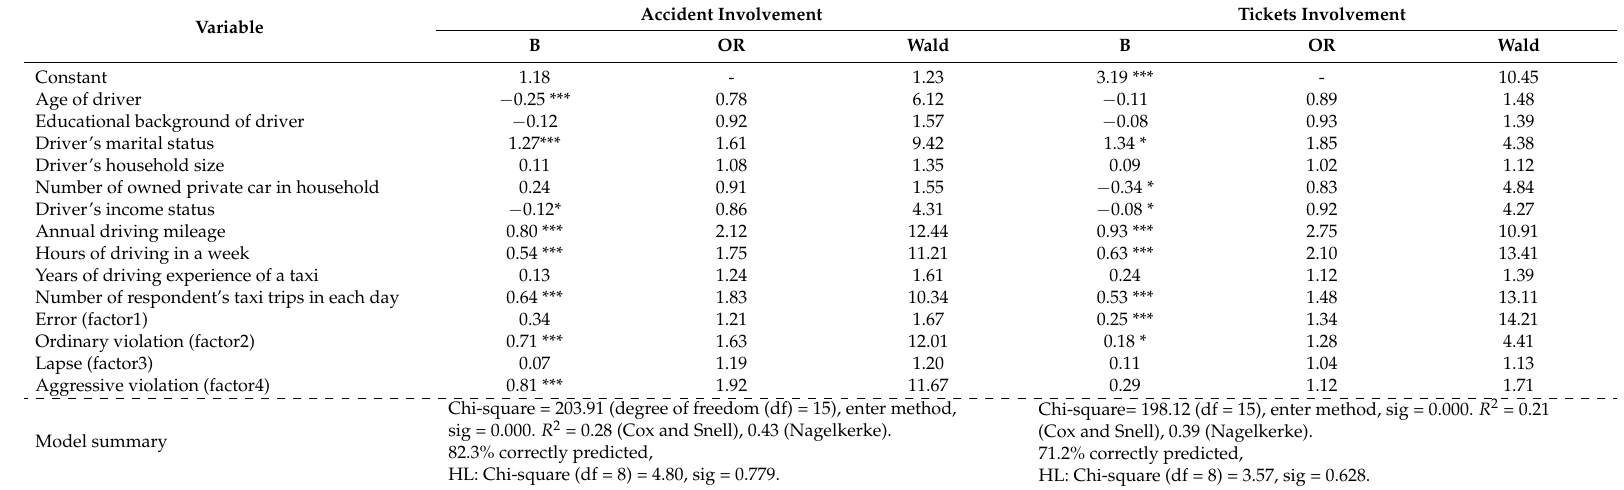
Table 5. Predictors of the accident involvement and receiving traffic